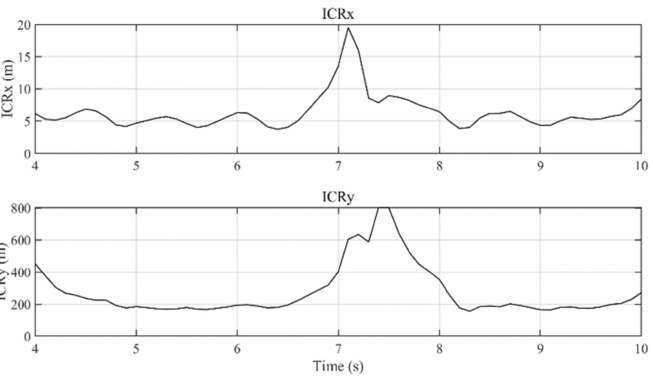
Figure 19. The instantaneous center of rotation (ICRs) of the vehicle when the vehicle